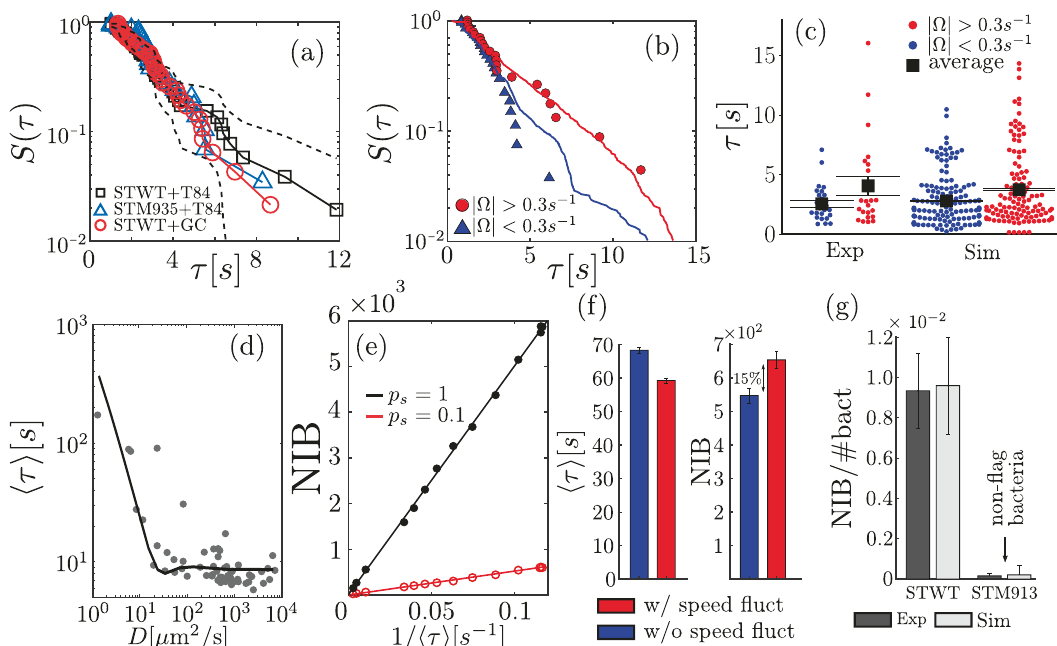
Fig. 5 Search time statistics and infection process. a Probability S ( τ ) that the search time is larger than τ in experiments with ST-WT ( n = 50) and ST- M935 ( n = 28), respectively, in the presence of T84 cells and in a control test (STWT + GC, n = 63), see text. The dashed curve represents the 95% con fi dence interval of S ( τ ) for ST-WT. b S ( τ ) for ST-WT with ∣ Ω ∣ > 0.3 s − 1 (red) and ∣ Ω ∣ < 0.3 s − 1 (blue) in experiments (symbols, n = 27 and n = 23) and simulations (curves, n = 1445 and n = 1169); in c the corresponding search time distribution and their average (black square) 〈 τ 〉 is shown. d 〈 τ 〉 as function of D : the solid curve was computed using a representative bacterium whose motility parameters correspond to average values, except for Ω that is used to vary D ; dots correspond to estimates using individual motility parameters. e Number of invading bacteria (NIB) vs 1/ 〈 τ 〉 for two infecting probabilities: symbols correspond to simulations and straight lines to linear fi ts. f 〈 τ 〉 and NIB with (w/) and without (w/o) speed fl uctuations for Ω = 2.5 s − 1 in simulations. g Percentage of NIB with respect to the total number of bacteria (#bact) calculated in experiments (dark gray, n = 3)and in simulations (light gray) with ST-WT and with non- fl agellated mutant ST-M913; see Methods and Supplementary Note 7. Error bars in c , f , and g correspond to the standard error of the mean (SEM) for 〈 τ 〉 and standard error (SE) for